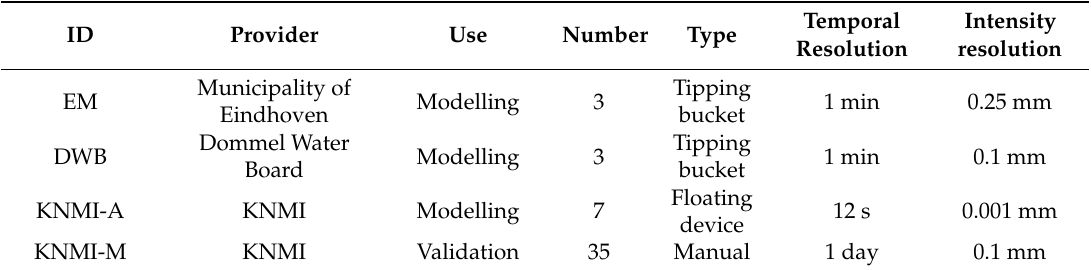
Table 1. Summary of the available rain gauge networks, their characteristics and how they are used in this